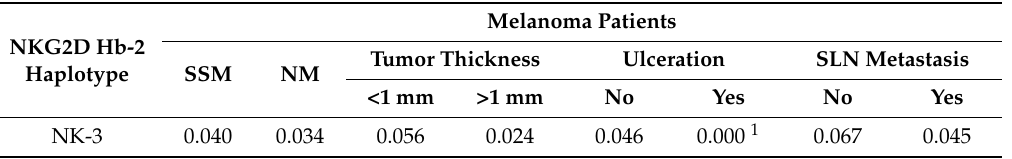
Table 6. Frequency of the NK-3 haplotype of the NKG2D Hb-2 block in melanoma patients according to histological and clinical characteristics at diagnosis.